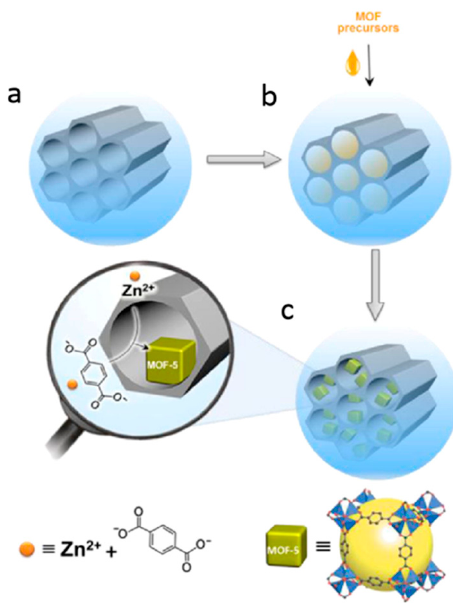
Figure 9. ( a ) Dispersion of mesoporous silica (SBA-15) in hydrophobic n-octane; ( b ) addition of the hydrophilic N , N -dimethylformamide (DMF) solution containing MOF precursors (metal ions and ligands); ( c ) formation of MOFs at 120 ◦ C for 24 h. Reproduced from [70], with permission from American Chemical Society,